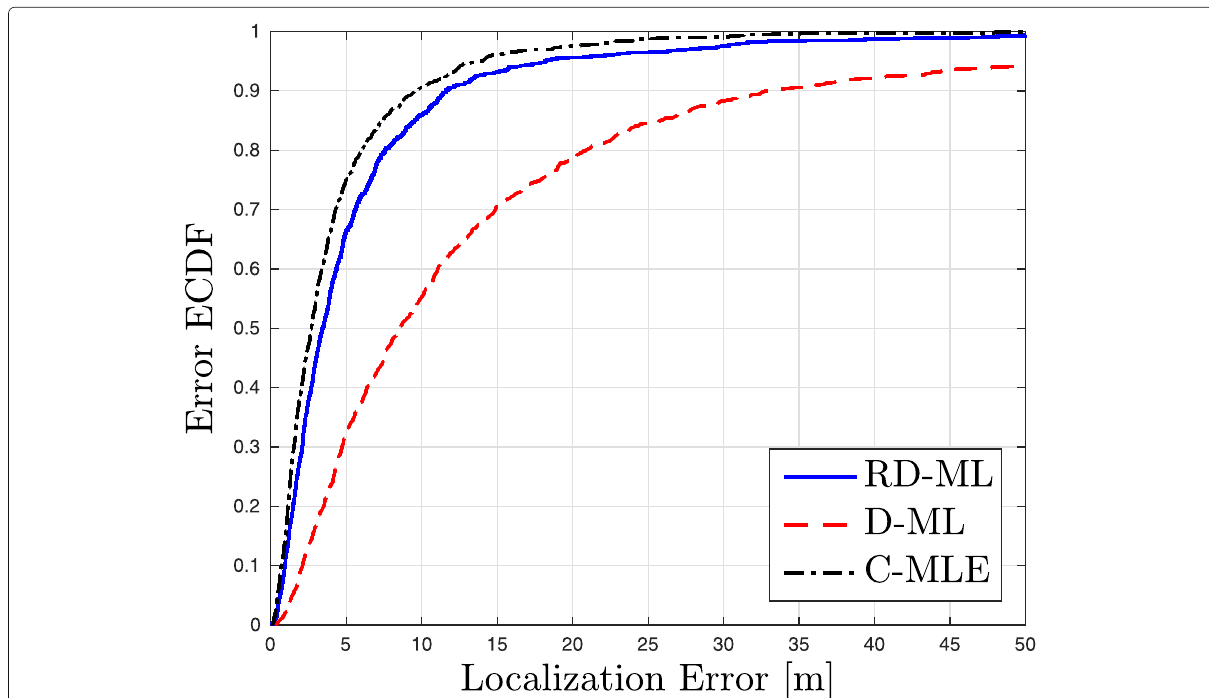
Fig. 6 Mixed LoS/NLoS scenario with white Gaussian noise. Fully connected networks, randomized NLoS fraction, N a = 11, N u = 10